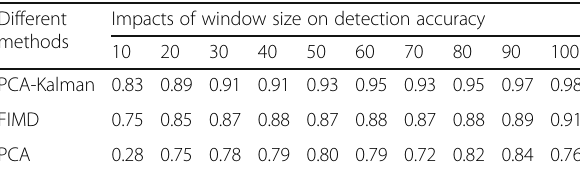
Table 6 The effect of the window size of different methods on the detection accuracy Different Impacts of window size on detection accuracy methods